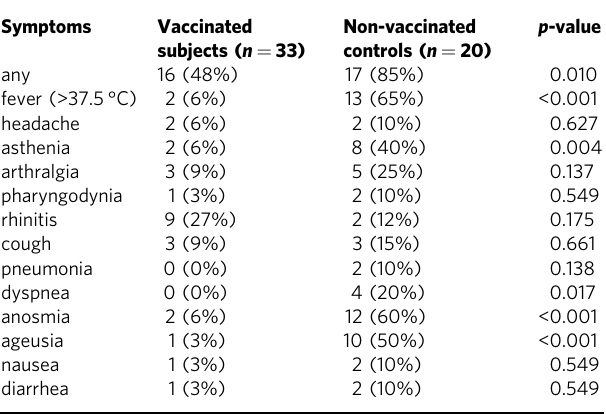
Fig. 1 Study pro fi le. Data from 4066 healthcare workers of San Matteo hospital, Pavia, Italy were analysed: 3720 subjects received a complete schedule of BNT162b2 vaccine, while 346 subjects who did not receive vaccination during the study period were used as controls. According to serological or virological data subjects were considered SARS-CoV-2 experienced or naïve before initiation of the study, while SARS-CoV-2 serostatus was unknown or dubious for some individuals. SARS-CoV-2 infection was diagnosed during the study in 33 vaccinated subjects and 20 controls. Table 1 Symptoms of SARS CoV in vaccinated and non- vaccinated